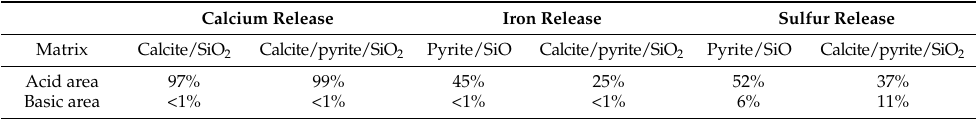
Table 1. Contents of release elements in solution as a function of mixture and pH area